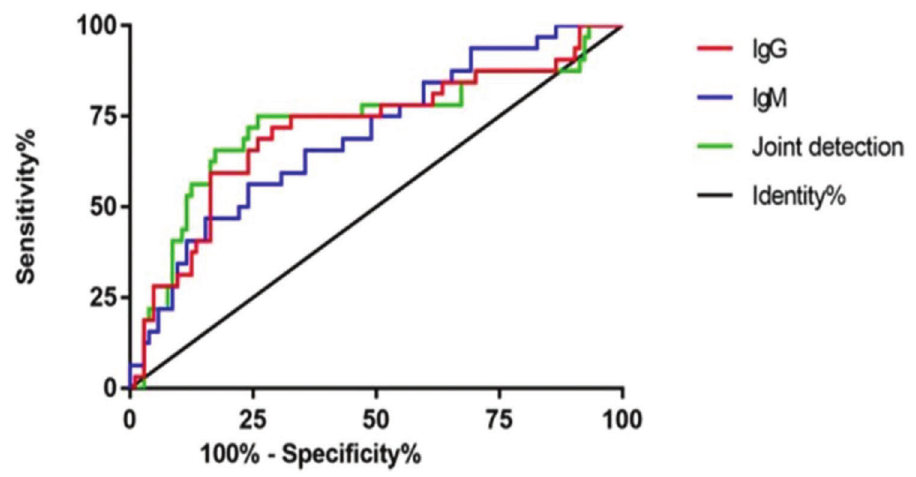
Figure 4 - Receiver operating characteristic curves of IgG and IgM. The area under the curve (AUC) of IgG was 0.713; when the specificity was 82.69% and the sensitivity was 59.38%, the optimal cut-off value was 17.458, and the Youden index was 42.07%. The AUC of IgM was 0.696; when the specificity was 75.00% and the sensitivity was 56.25%, the optimal cut-off value was 24.020, and the Youden index was 31.25%. The AUC of the combined detection was 0.727; when the specificity was 74.04% and the sensitivity was 71.88%, the optimal cut-off value was 0.273, and the Youden index was